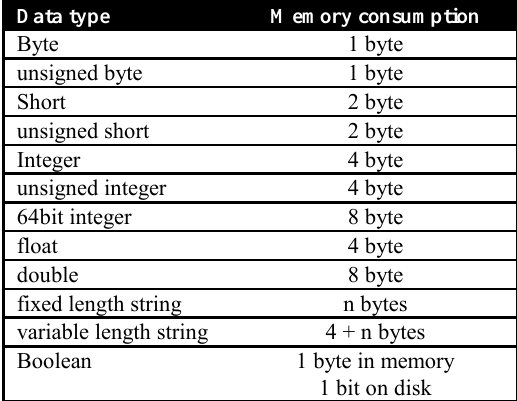
Supported data attribute types and their memory